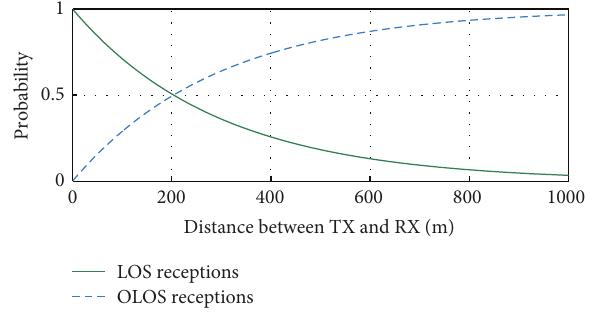
Figure8:TheprobabilityofLOSandOLOSwithrespecttodistance, and it can be seen that the probability of being in LOS decreases as the distance